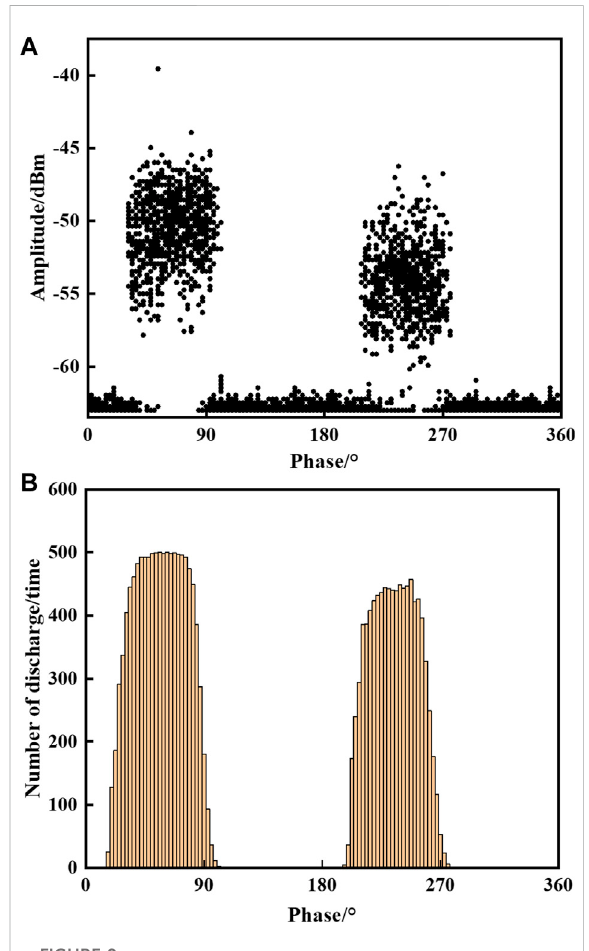
FIGURE 10 HFCT signals of surface discharge at 50.25 kV. (A) PRPD pattern. (B) φ −